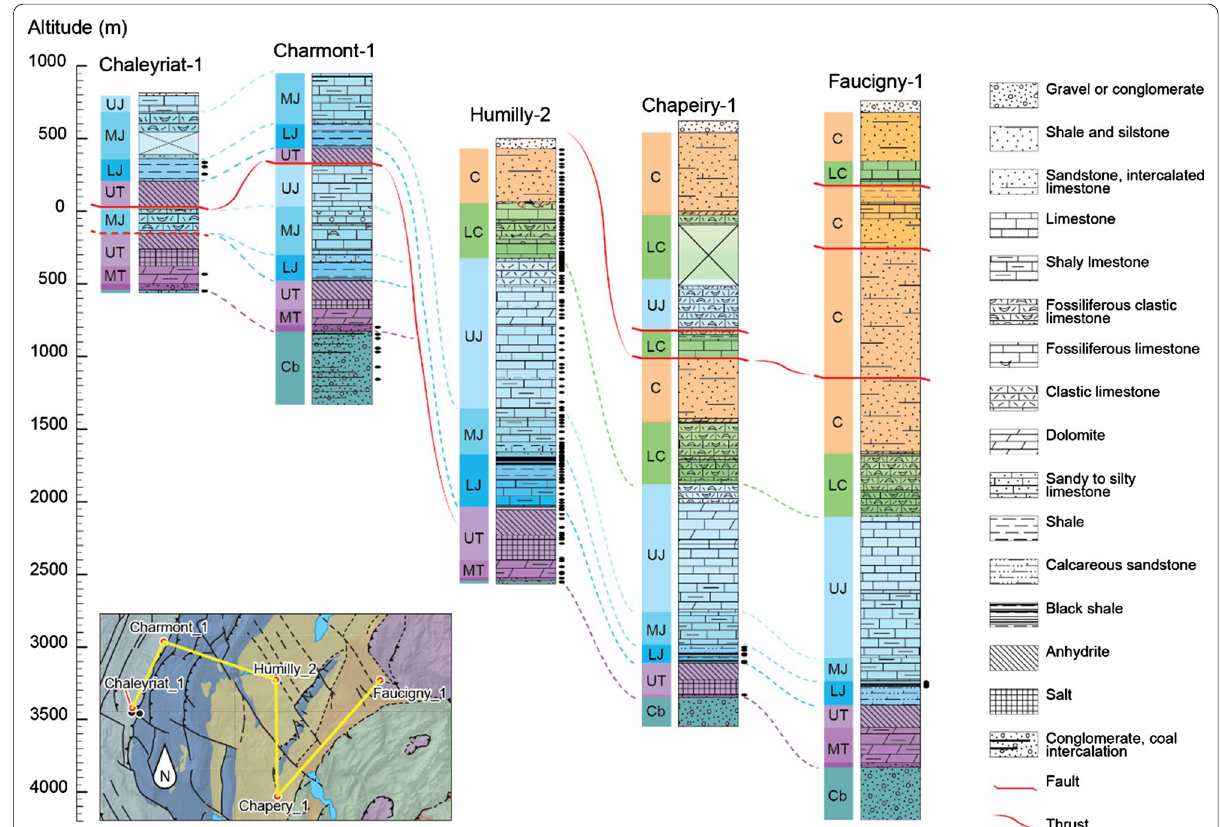
Fig. 3 Synthetic W-E cross-section and well correlation between Chaleyriat-1, Charmont-1, Humilly-2, Chapeiry-1 and Faucigny-1 wells, representing the stratigraphic columns and the projected geological contacts. Black ellipses represent the sampled intervals for Rock–Eval pyrolysis. C: Cenozoic; LC: Lower Cretaceous; UJ: Upper Jurassic; MJ: Middle Jurassic; LJ: Lower Jurassic; UT: Upper Trias; MT: Middle Trias; LT: Lower Trias; Cb: